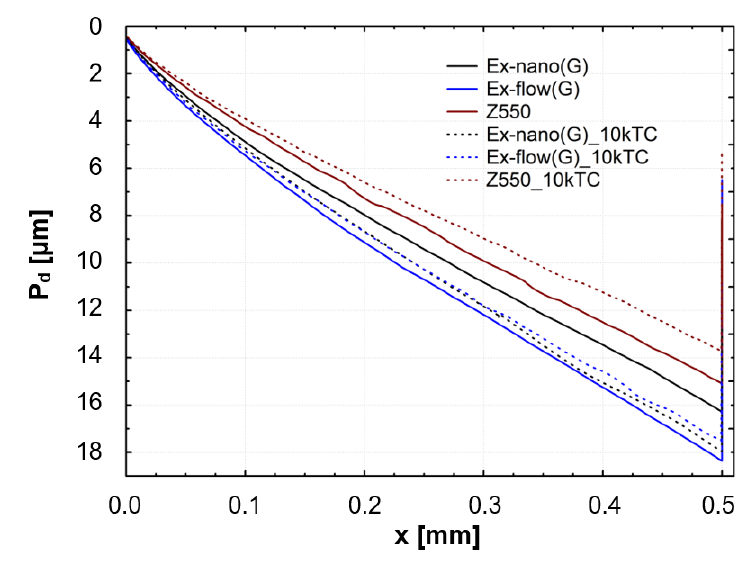
Figure 5. Mean curves of the coefficient of friction ( μ ) as a function of the indenter position (x).